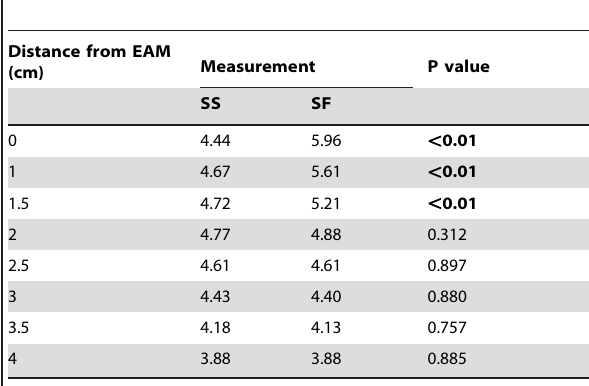
Table 4. P value for Squamous suture and Sylvian fissure in each location measured (Left).